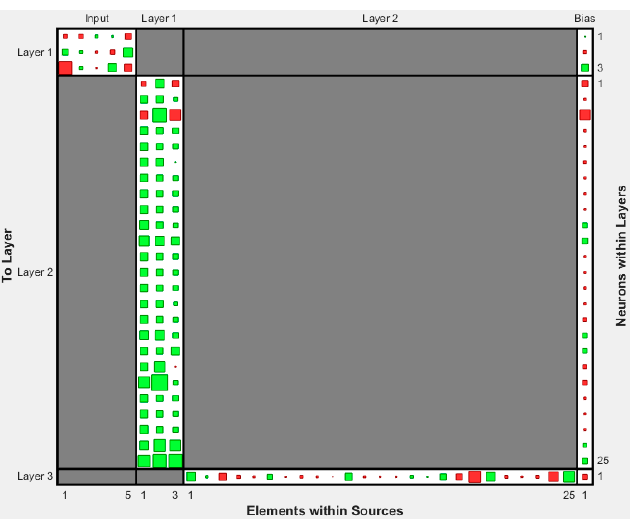
Figure 11. Final Weights and Bias Values of the optimum FF-NN model 5-3-25-1 for the case of modulus of elasticity of sandcrete materials (The values are presented in Table